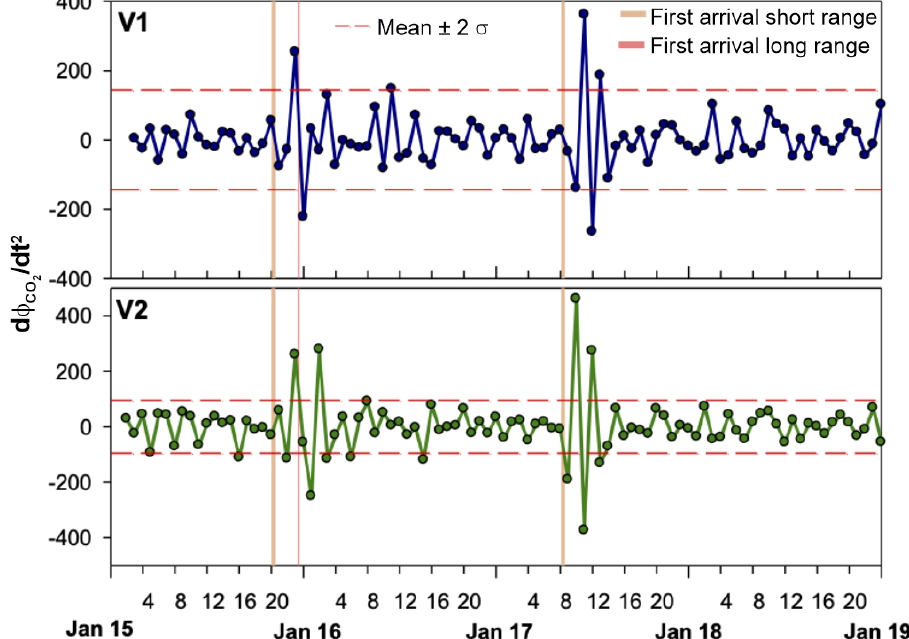
Figure 8. Second time derivative of hourly values of soil CO 2 flux ( ϕ , g m − 2 d − 1 ) measured in two monitoring stations (see methods) on the island of Vulcano (Figure 1), compared to its mean value ± 2 σ for the considered period. First arrival times of the first and second passage of the shockwave travelling along the short and long ranges are also reported.